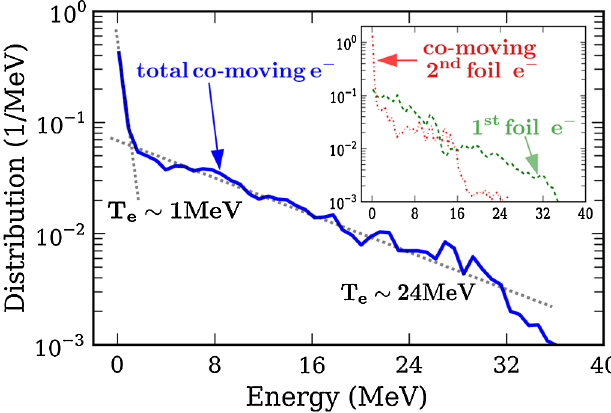
FIG. 3. The energy distribution of the comoving electrons (solid, blue), the electrons from the first foil (dashed, green), and the second foil (dotted, red). The distribution of the electrons from the first foil is measured at the front side of second foil for a slab with thickness of three skin depths at t ¼ 142 fs . The distributions of the second foil electrons and the comoving electrons are taken around the ion beam between x ¼ x ¼ 1650 c=! t ¼ 156 fs 1550 c=! pe and pe (see Fig. 2) at